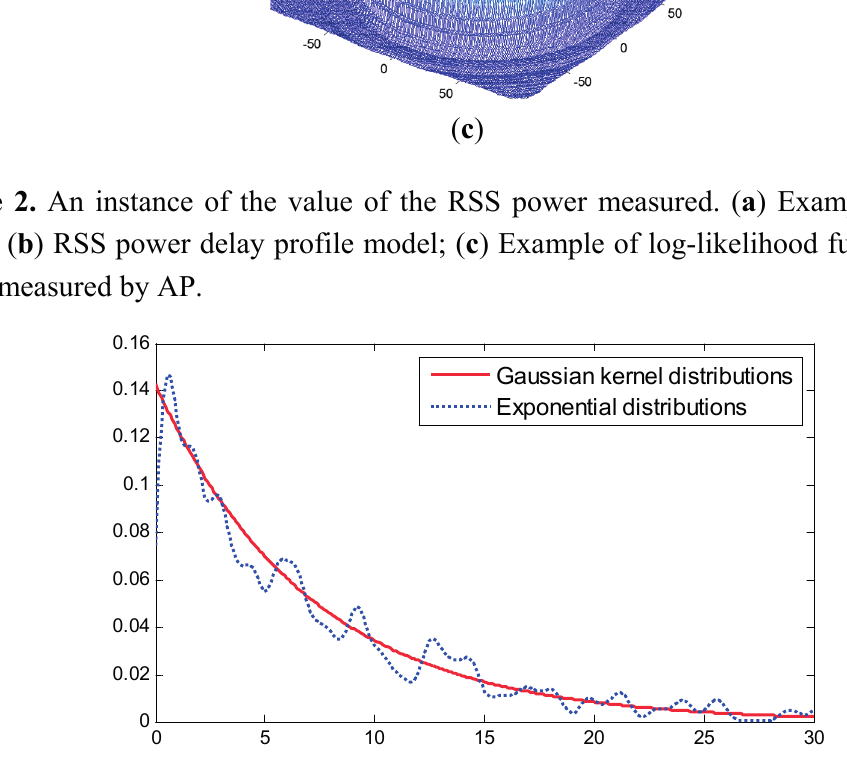
Figure 3. PDF comparison for Gaussian kernel distributions and exponential